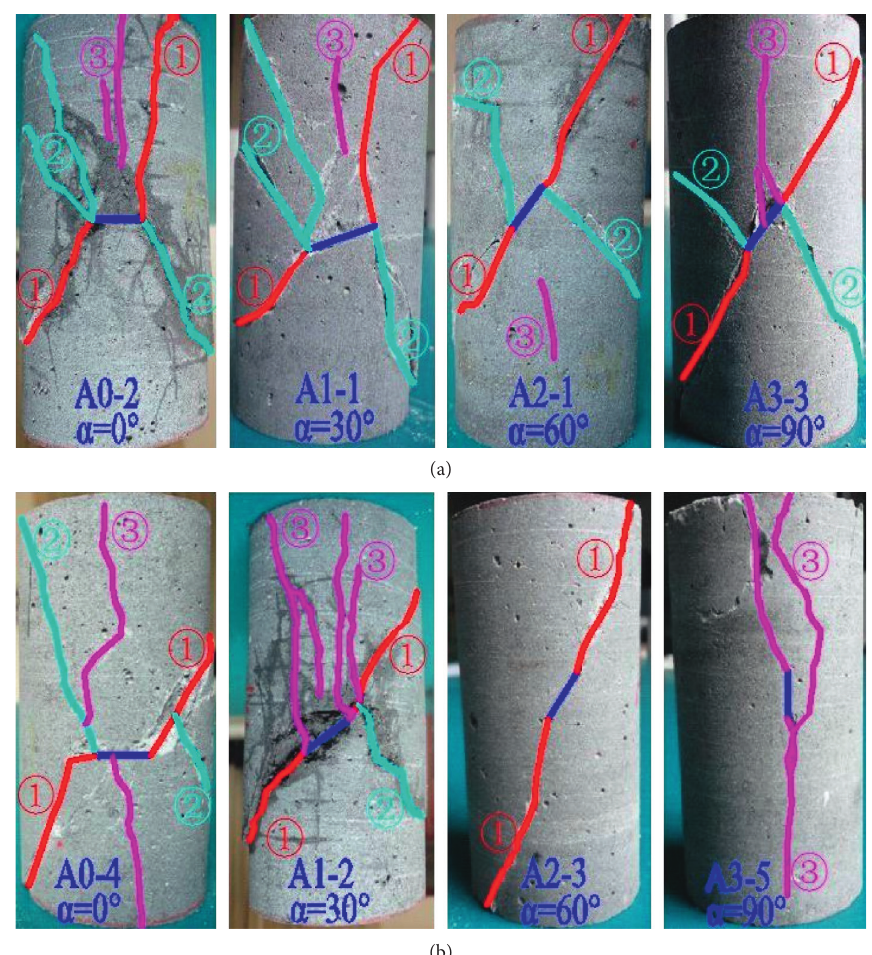
Figure 11: Failure modes of rock-like specimens with preexisting fissures under type I (a) and II (b) tests. ① , ② , and ③ represent wing cracks, antiwing cracks, and tensile cracks,